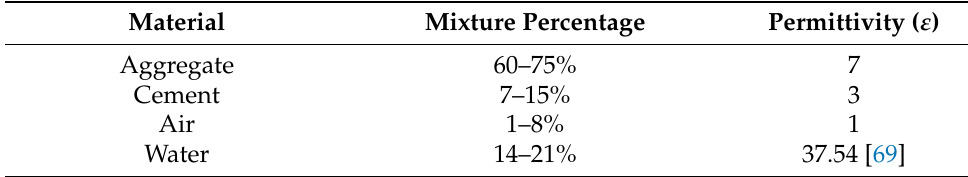
Table 1. The range of components used to generate the training data. Notice that the water is assumed to be bound and therefore its relaxation frequency is shifted to lower frequencies which results to a lower permittivity value for the frequency range of interest [69]. The percentages of the components are for on service